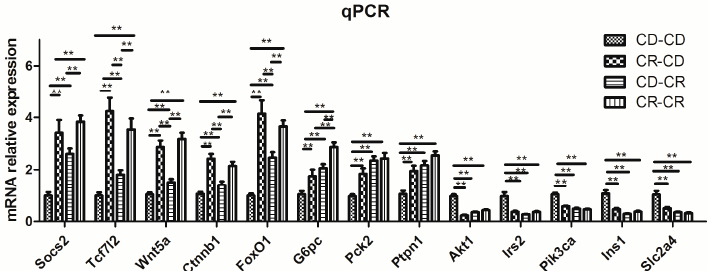
Figure 3. Validation of differentially-expressed genes by real-time PCR. Socs2 : suppressor of cytokine signaling 2; Akt1 : thymoma viral proto-oncogene 1; Irs2 : insulin receptor substrate 2; Pik3ca : phosphatidylinositol 3-kinase, catalytic, alpha polypeptide; Tcf7l2 : transcription factor 7 like 2; Wnt5a : wingless-type MMTV integration site family, member 5A; Ctnnb1 (catenin, beta 1): catenin (cadherin associated protein), beta 1; FoxO1 : forkhead box O1; G6pc : glucose-6-phosphatase, catalytic, Ins1 : insulin 1; Pck2 ( Pepck ): phosphoenolpyruvate carboxykinase 2; Slc2a4 ( Glut4 ): solute carrier family 2 member 4; Ptpn1 (Ptp1b ): protein tyrosine phosphatase, non-receptor type 1. CD, control